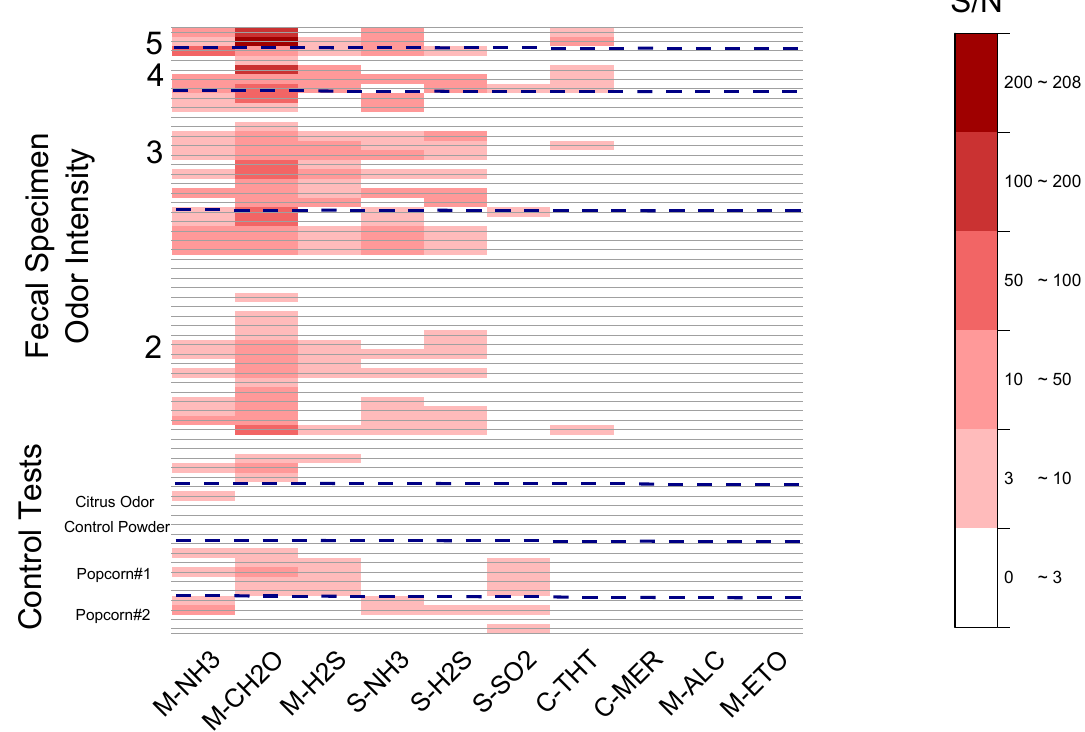
Figure 4. Heatmap showing the signal to noise (S/N) ratios to 64 odorant exposures for the 10 sensors tested. The horizontal dashed lines separate the different odor intensity levels.